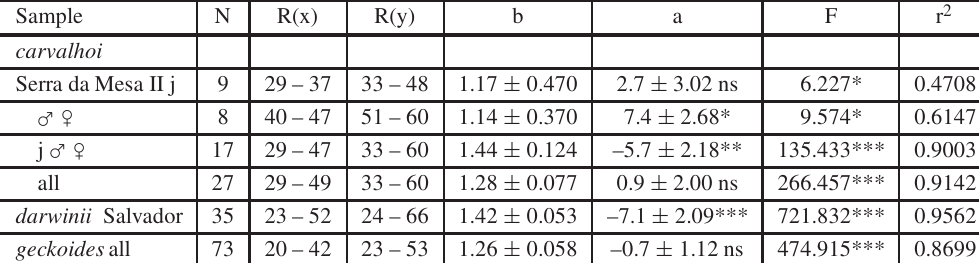
Gymnodactylus, statistics of the regression of tail length on body